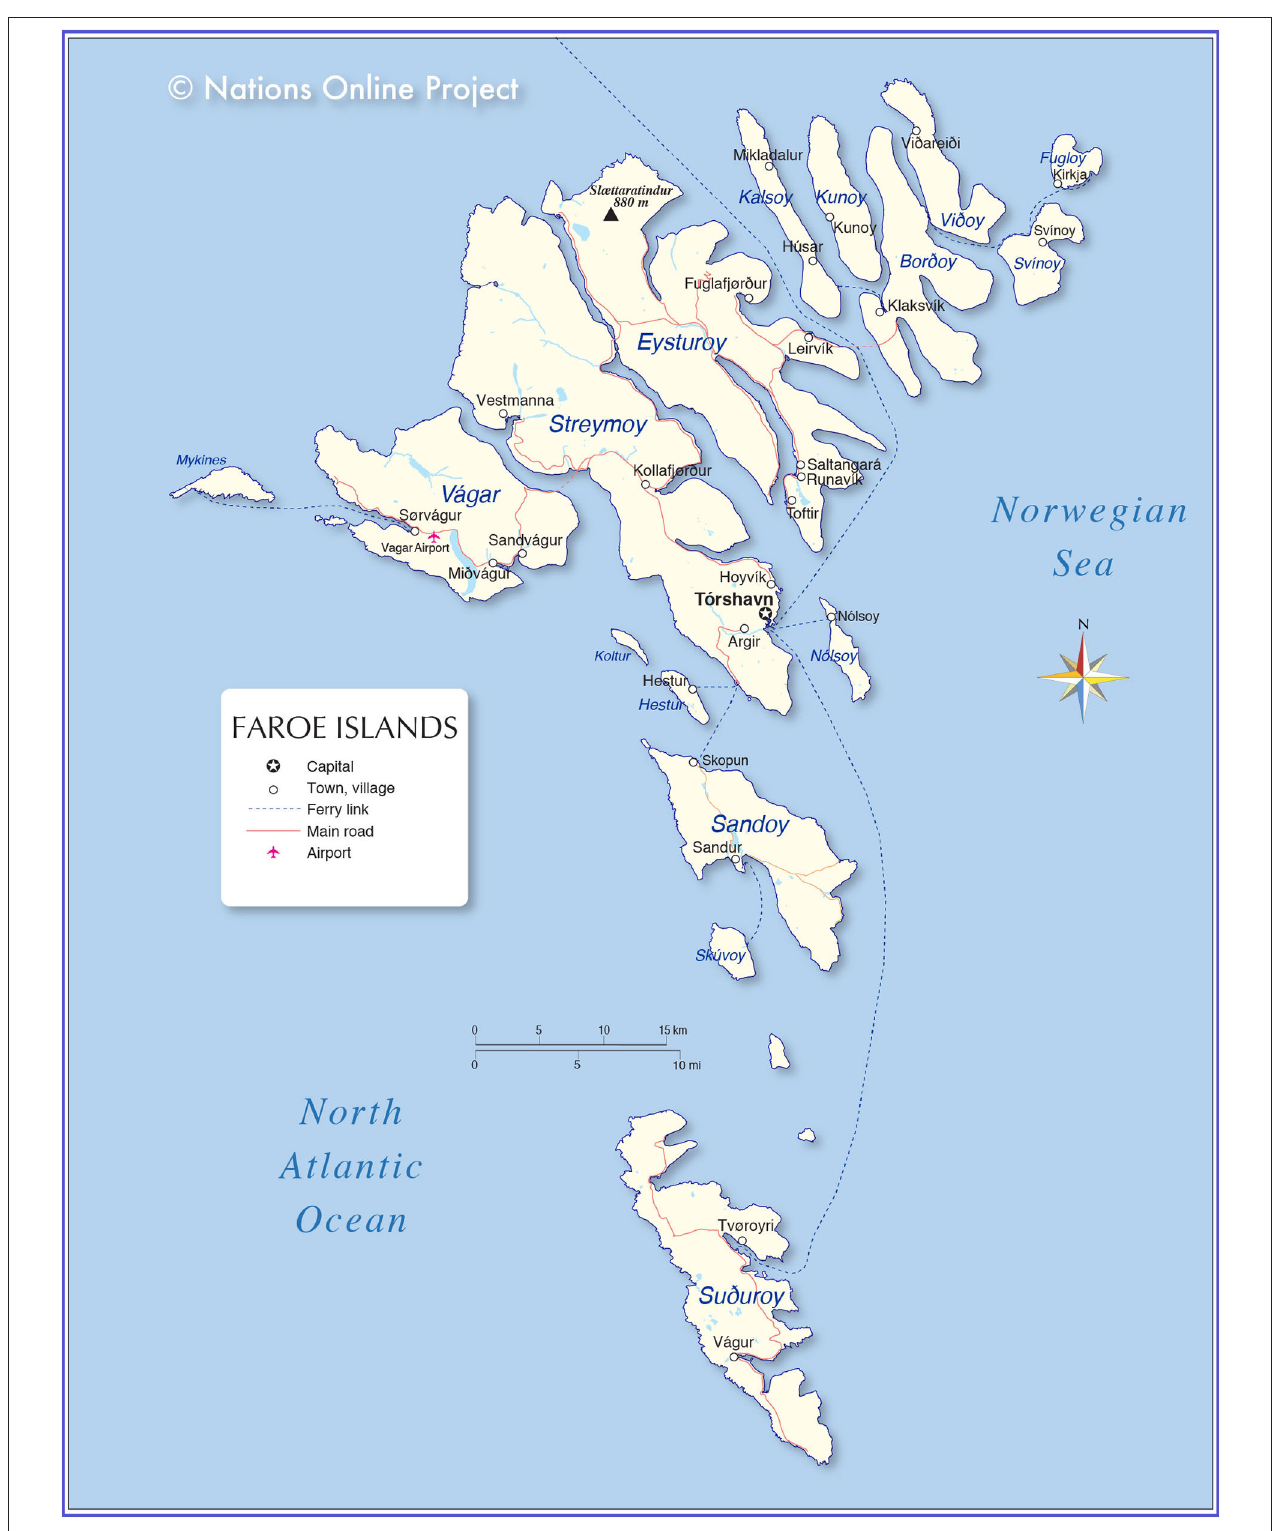
FIGURE 7 | Map of the Faroe Islands (Courtesy Nation Online